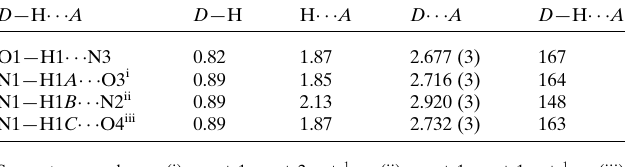
Table 2 Hydrogen-bond geometry (A˚ , (cid:5) ) for Ib .